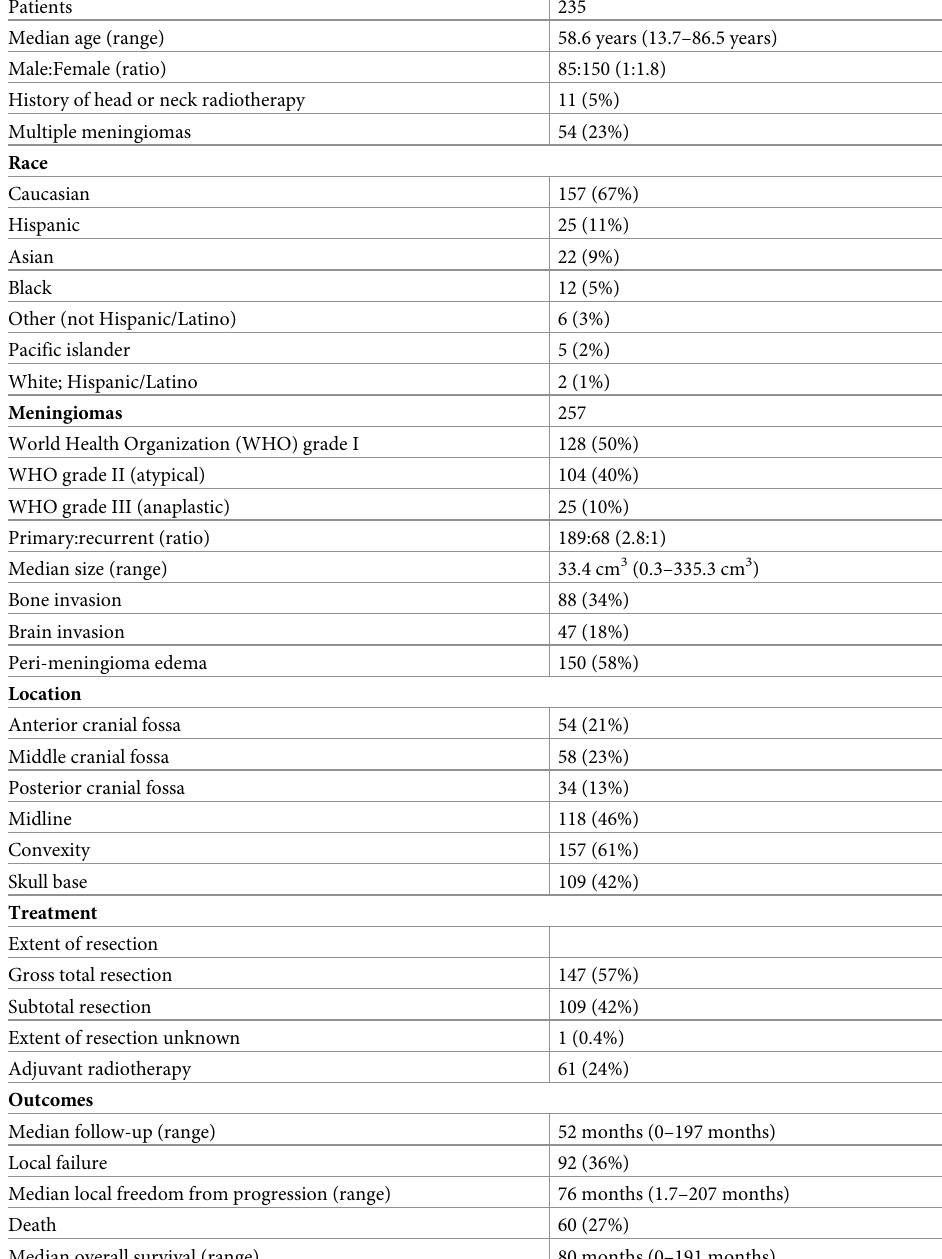
Table 2. Patients, meningiomas, treatments and outcomes.